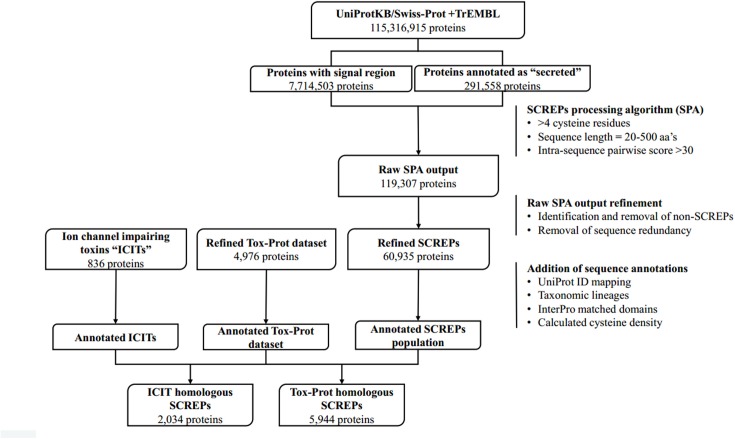
SCREPs data mining pipeline. An overview of the entire SCREPs data mining pipeline, from the generation of SCREP sequences originating from UniProtKB, up to methods of data refinement as well as population and sequence analysis. Beneath each major step is the resulting number of protein sequences with additional details toward the right, outlining important elements within the major steps of the SCREPs processing algorithm (SPA), data refinement, and application of dataset annotations.